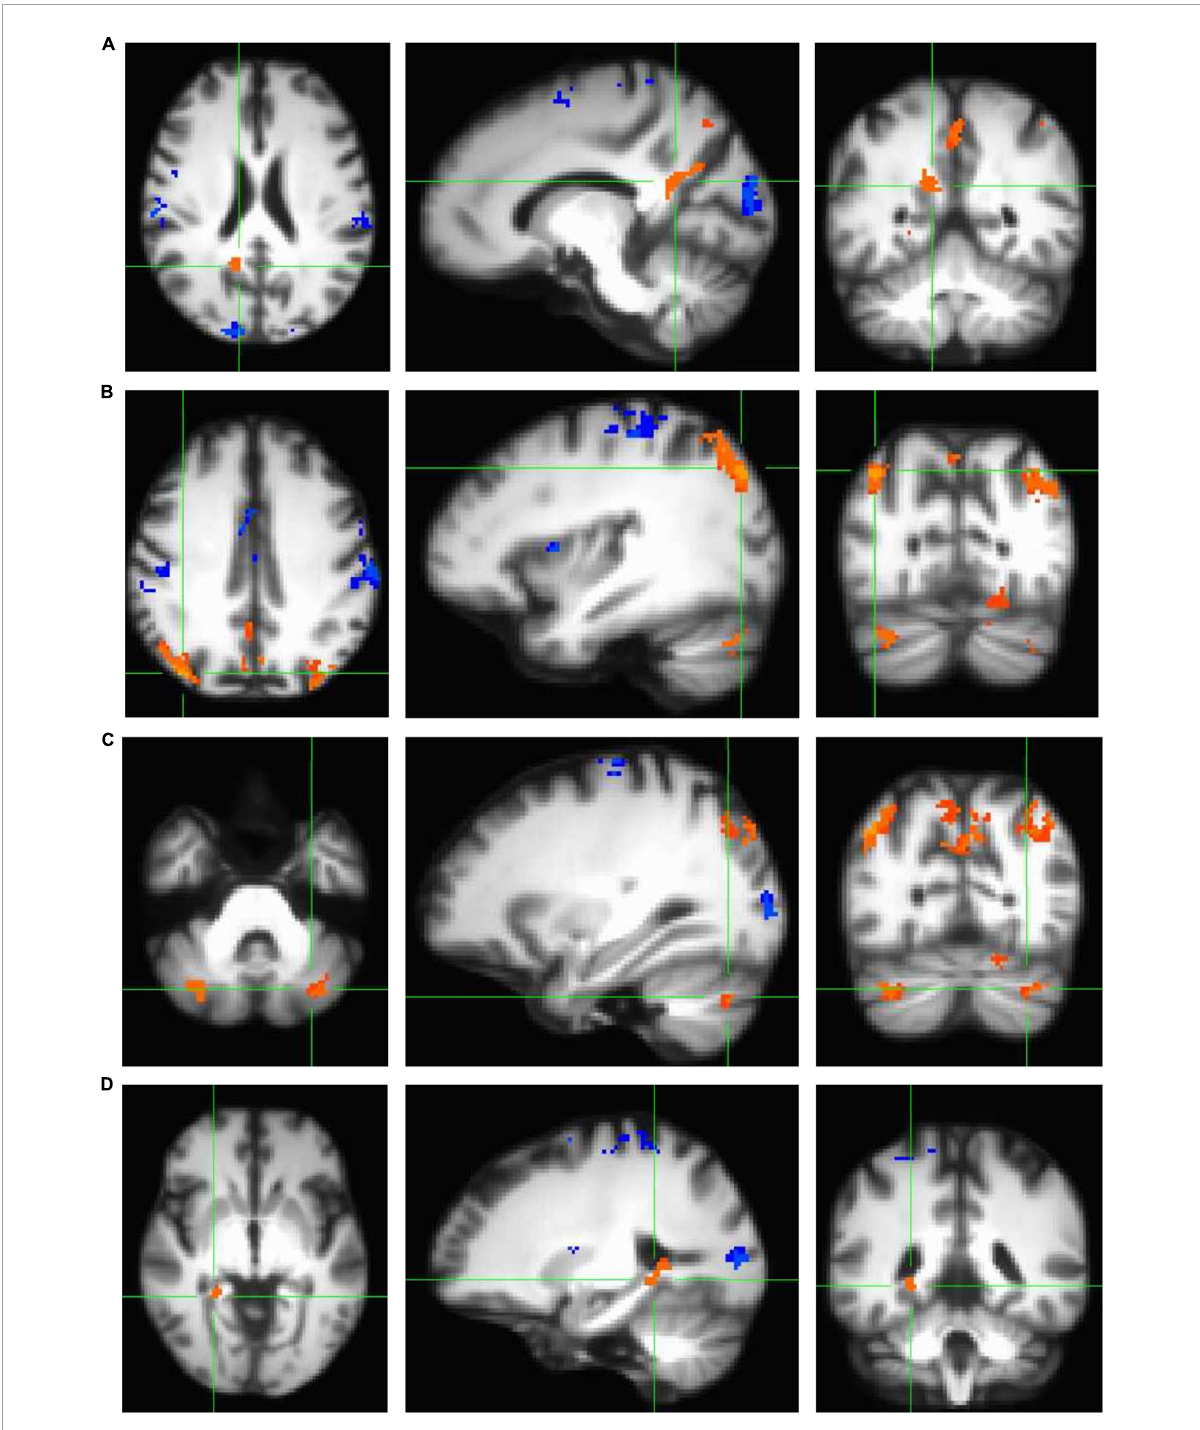
FIGURE3 Clusters that demonstrated statistically significant activation ( p < 0.001) during the navigation task in encoding > control conditions (orange) and control > encoding conditions (blue) as measured using a standard univariate analysis in AFNI ( 3dttest ++ with ETAC). All clusters shown here survived correction for multiple comparisons and are demonstrated on the age-specific MRI brain template warped to MNI space. Note that all four panels (A–D) show a significant encoding > control cluster in three planes, listed left to right: axial (left = right hemisphere), sagittal (left = anterior), and coronal (left = right hemisphere). (A) Significant cluster comprising the bilateral retrosplenial cortex and right precuneus. (B) Two significant clusters comprising bilateral inferior parietal cortex. (C) Two significant clusters comprising the bilateral cerebellum (lobule VIIa Crus I and II). (D) Significant cluster comprising the medial temporal areas, including right fusiform gyrus, right parahippocampal gyrus (and more specifically, parahippocampal cortex), right lingual gyrus, and right